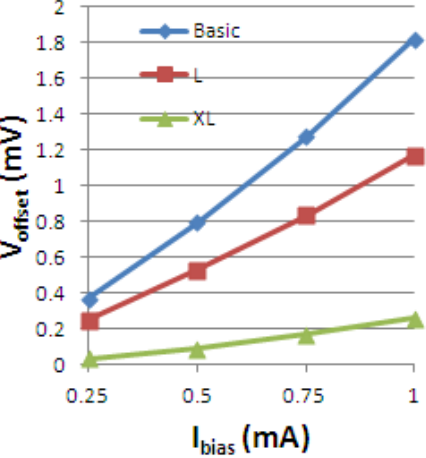
Figure 24. The measured single phase offset vs. biasing current for the integrated cross-like Hall Effect devices.